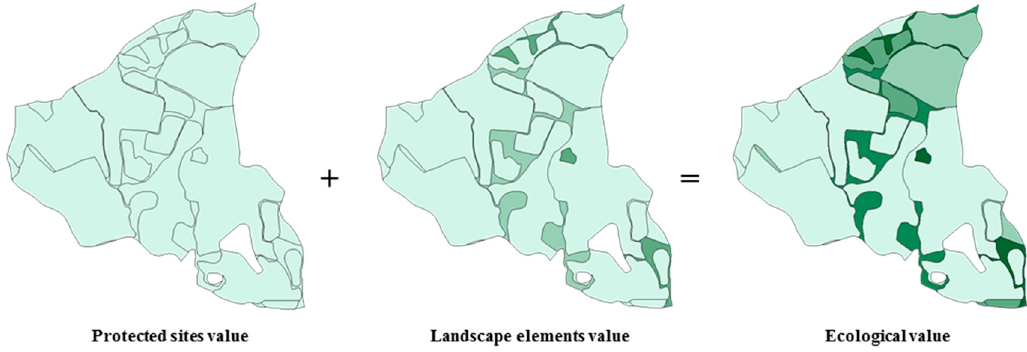
Figure 16. Parcel sample showing the ecological value report; the result of the added values from protected sites and landscape elements.